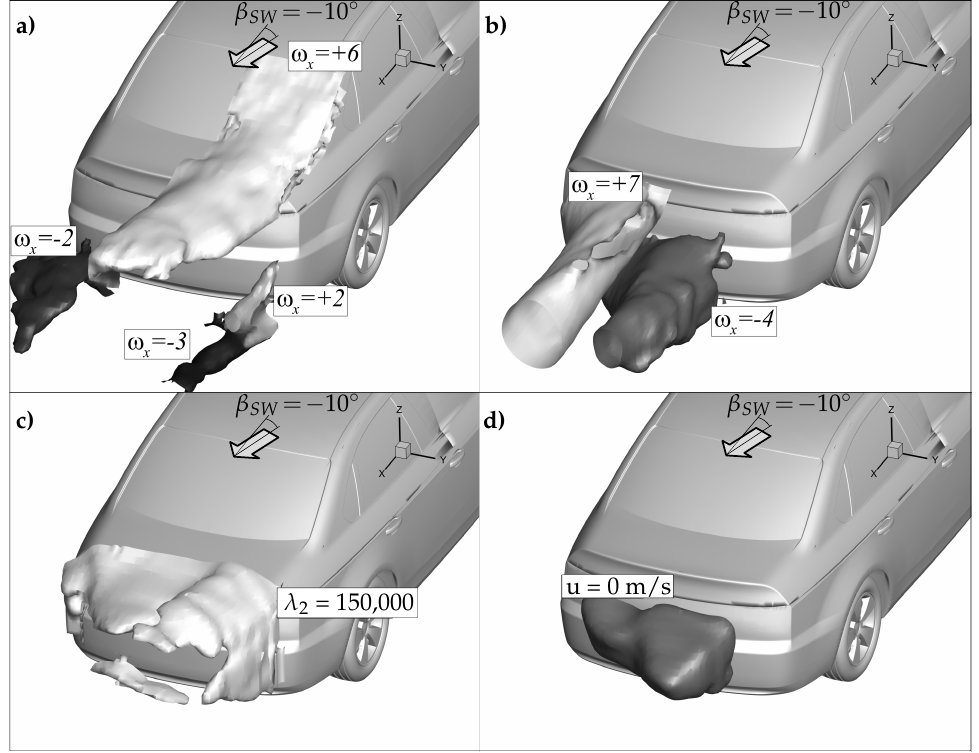
10 ◦ : ( a , b ) streamwise vortices, ( c ) λ 2 -criterion, −